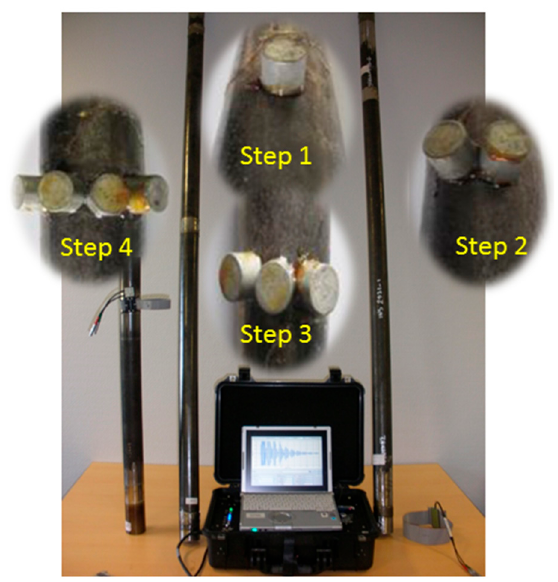
Figure 5. Experimental setup of the guided waves monitoring technique of a tube, and photography showing the adopted method to create a structural defect.